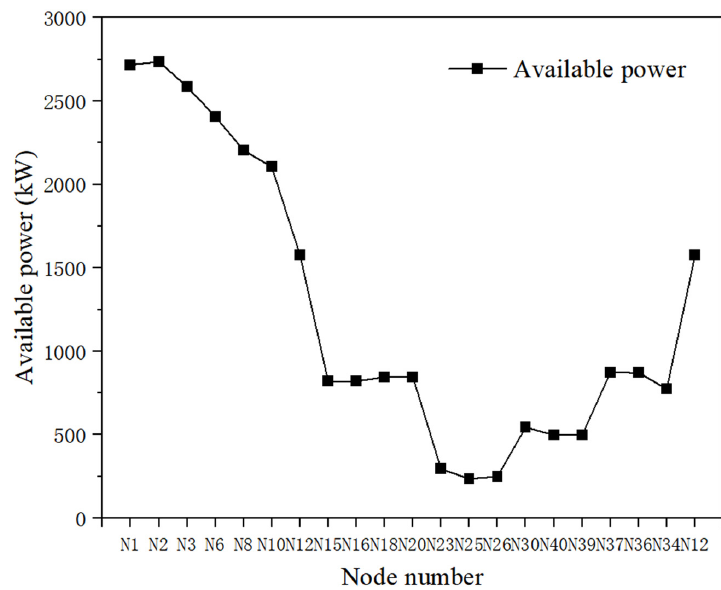
Figure 7. Available thermal power of typical nodes in Case II. Nodes N15, N18, N30 and N36 are mixed nodes in the heating network, and two branch thermal masses from different heat sources converge at these nodes. Table 4 lists the related thermodynamic parameters of these four nodes, including the entropy flow, available power and heat before and after the node confluence. The heat of the working medium is calculated according to Equation (14). It can be seen that the node entropy flow is increased compared with the algebraic sum of each branch entropy flow, which implies there is an entropy increase in the mixing process. While the available thermal power of the node is reduced compared with the algebraic sum of each branch, which reflects that the irreversible entropy generation at the node leads to the loss of available thermal power. From Table 4, it is clear to see that the heat before and after the confluence is con- served, but the entropy is increased, simultaneously accompanied by the decline of avail- able thermal power. This suggests that entropy flow is more suitable for evaluating energy quality than temperature property. Table 4. Related thermodynamic parameters of typical heating network nodes Case II. Pipe Net- work Node